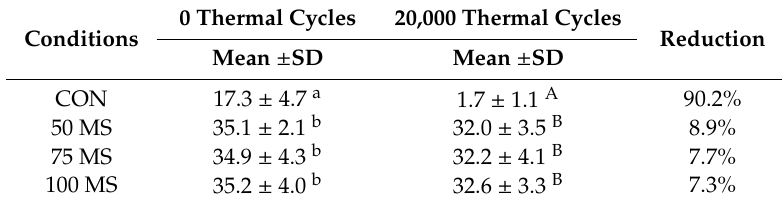
Table 3. Mean shear bond strengths (MPa) of acrylic resin bonded to Ce-TZP / A.